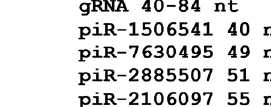
Figure 3. Nucleotide sequences of four piRNAs and the gRNA BS in a region from 40 nt to 84 nt. Note: The piRNA nucleotides that form canonical pairs with gRNA are highlighted in green and non ‐ canonical pairs are highlighted in blue. The piRNA nucleotides that do not interact with gRNA are highlighted in red. The names of the piRNAs are followed by the beginning of their BSs.